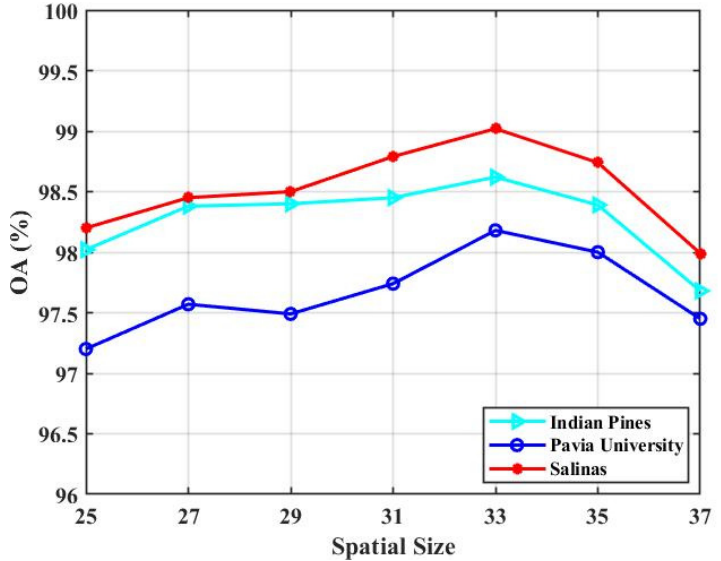
Figure 19. The classification result (OA) of our presented TSSFAN with different spatial size in Input- 2 for all three HSI datasets.